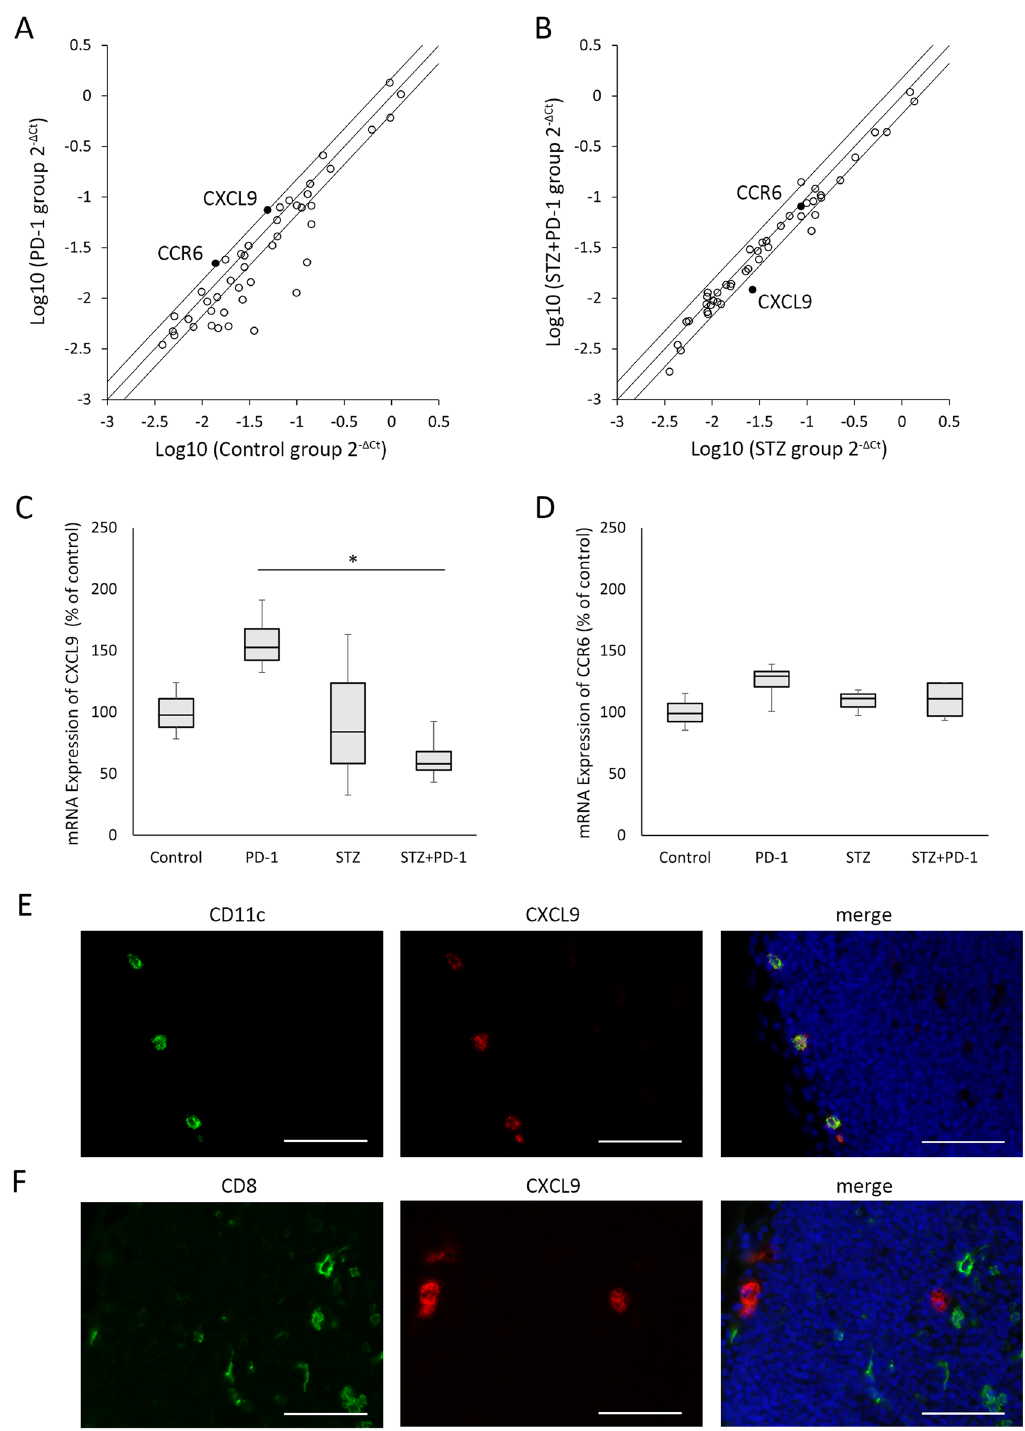
Figure 4. The mRNA expression levels of chemokines and chemokine receptors in dLNs from STZ-induced diabetic mice. ( A,B ) Scatterplot of mRNA expression levels of chemokines and chemokine receptors in dLNs of the control and PD-1 groups ( A ) and the STZ and STZ + PD-1 groups ( B ) analyzed by RT 2 Profiler PCR Array. The middle line indicates that the expression levels are equal between the two groups. The upper and lower lines indicate a 1.5-fold increase or decrease in the two groups. ( C,D ) The mRNA expression levels of CXCL9 ( C ) and CCR6 ( D ) as assessed by qRT-PCR in dLNs. Boxes indicate median values with the interquartile range, and whiskers indicate the lowest and highest values. One-way ANOVA and Tukey’s test were used in ( C,D ). *P < 0.05. ( E,F ) Double immunofluorescence microscopy shows the expression of CXCL9 (red) on CD11c + cells (green) ( E ) or CD8 + cells (green) ( F ) in dLNs, respectively. Scale bars, 50 µm. ANOVA Analysis of variance, CCR6 C–C motif chemokine receptor 6, CXCL9 C-X-C motif chemokine ligand 9, dLNs tumor-draining lymph nodes, PD-1 programmed